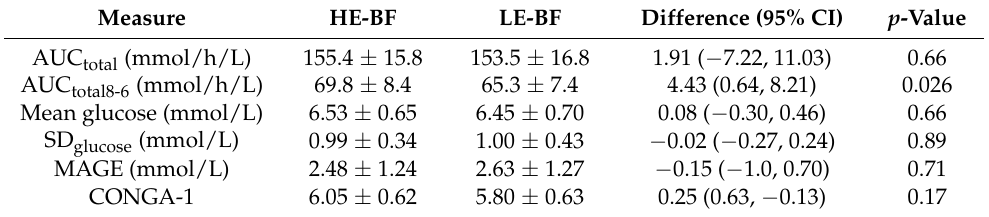
Table 3. Measures of glycaemia calculated from a continuous blood glucose monitor (CGM). Measurements from individuals with prediabetes ( n = 13) in response to a high-energy breakfast (HE-BF) or a low-energy breakfast (LE-BF). Measure